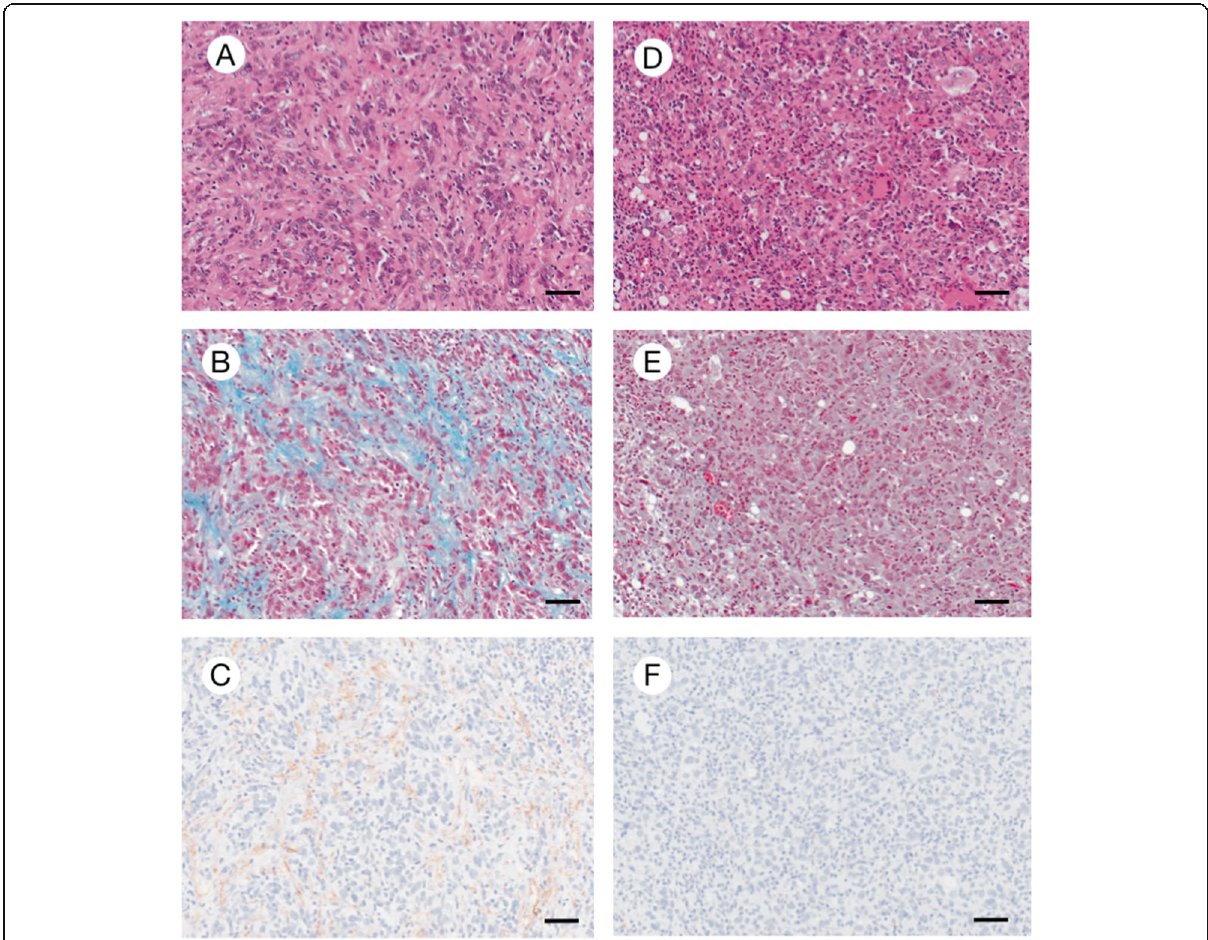
Fig. 3 Difference of Histological findings between the areas with and without eosinophilic infiltration: a-c ; Spindle neoplastic cells ( a ) were prone to present around no or scant eosinophilic infiltration area with fibrosis ( b , Elastica Masson-Goldner stain) and D2 – 40-positive lymphatic vessel proliferation ( c ). d-f ; Conversely, polygonal neoplastic cells ( d ) were prone to present around relative much eosinophilic infiltration area without evident fibrosis ( e , Elastica Masson-Goldner stain) and D2 – 40-positive lymphatic vessel proliferation ( f ). Bars, 50 μ